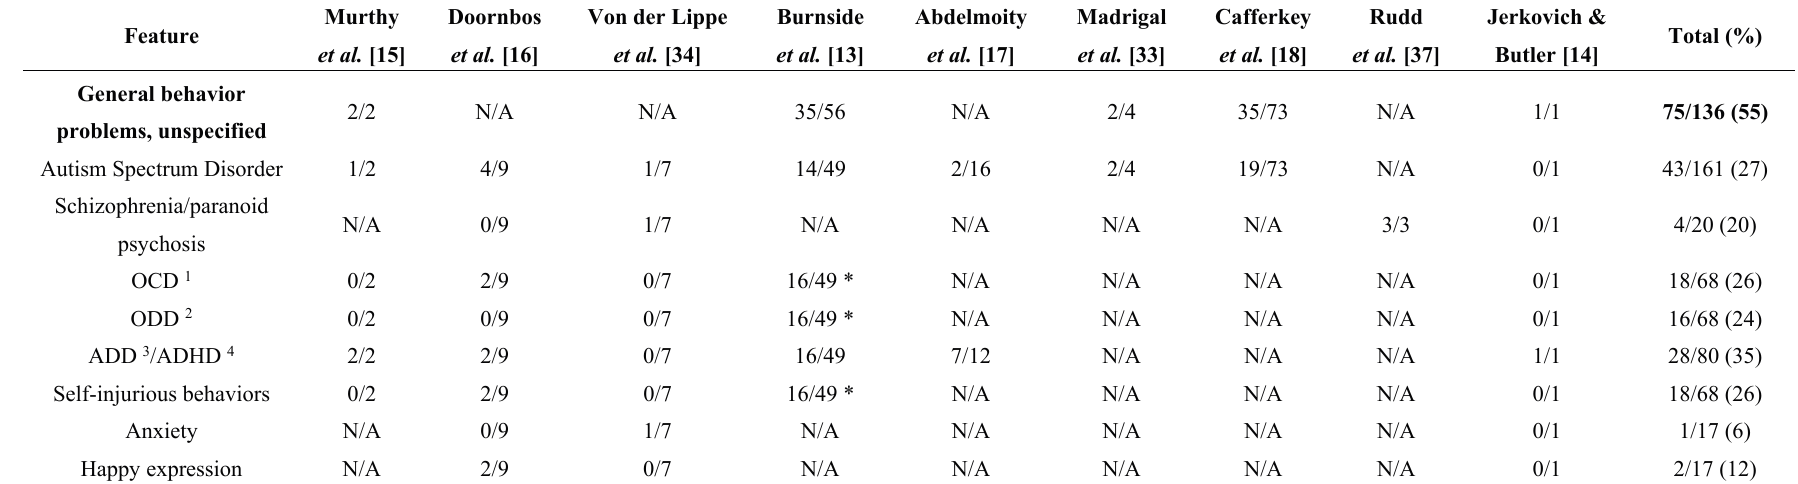
Table 4. Literature Review of Behavioral and Psychiatric Problems for Individuals with Chromosome 15q11.2 BP1–BP2 Microdeletion